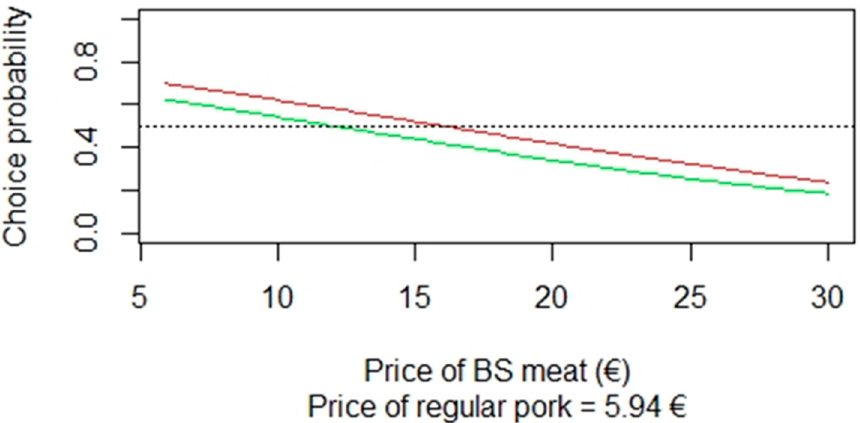
Figure 2. Probability of choosing an option among two alternatives.